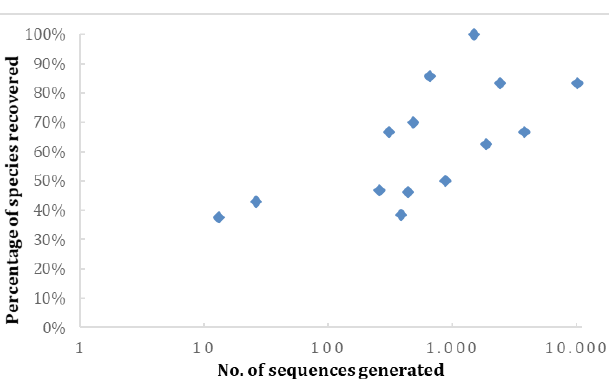
Fig 1 . Number of 454 sequences generated per sample in relation to the percentage of species recovered.